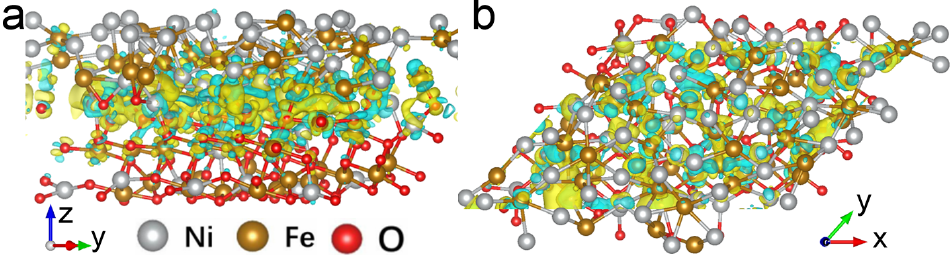
Figure 4. ( a ) Side and ( b ) top view of calculated charge density difference at the interface of NiFe and NiFe 2 O 4 . The blue and yellow regions represent electron depletion and accumulation, respec- tively.